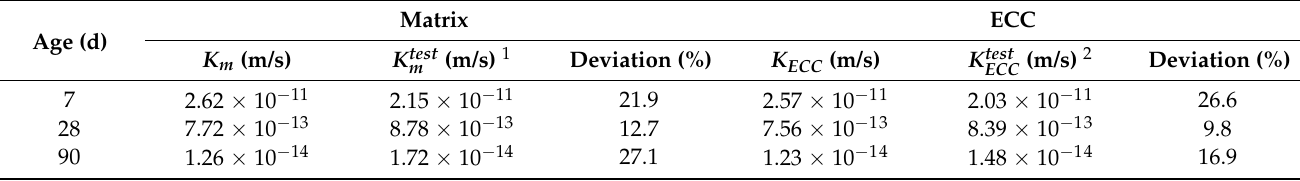
Table 5. Water permeability coefficients of ECC and its matrix